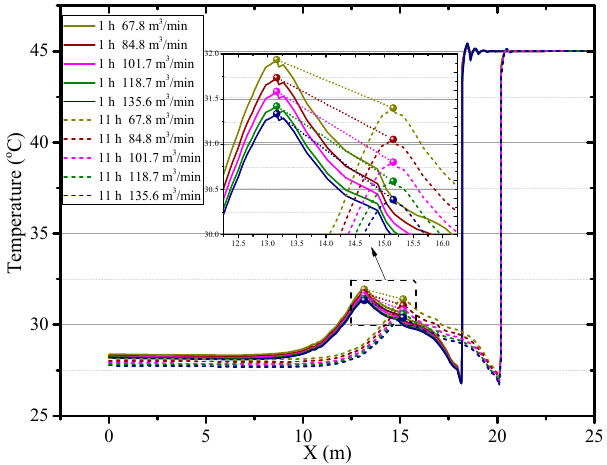
Figure 6. Air temperature distribution in roadway under different ventilation velocity: ( a ) air temperature in the Z = 0.5 m plane; ( b ) air temperature in the Y = 15 m section.